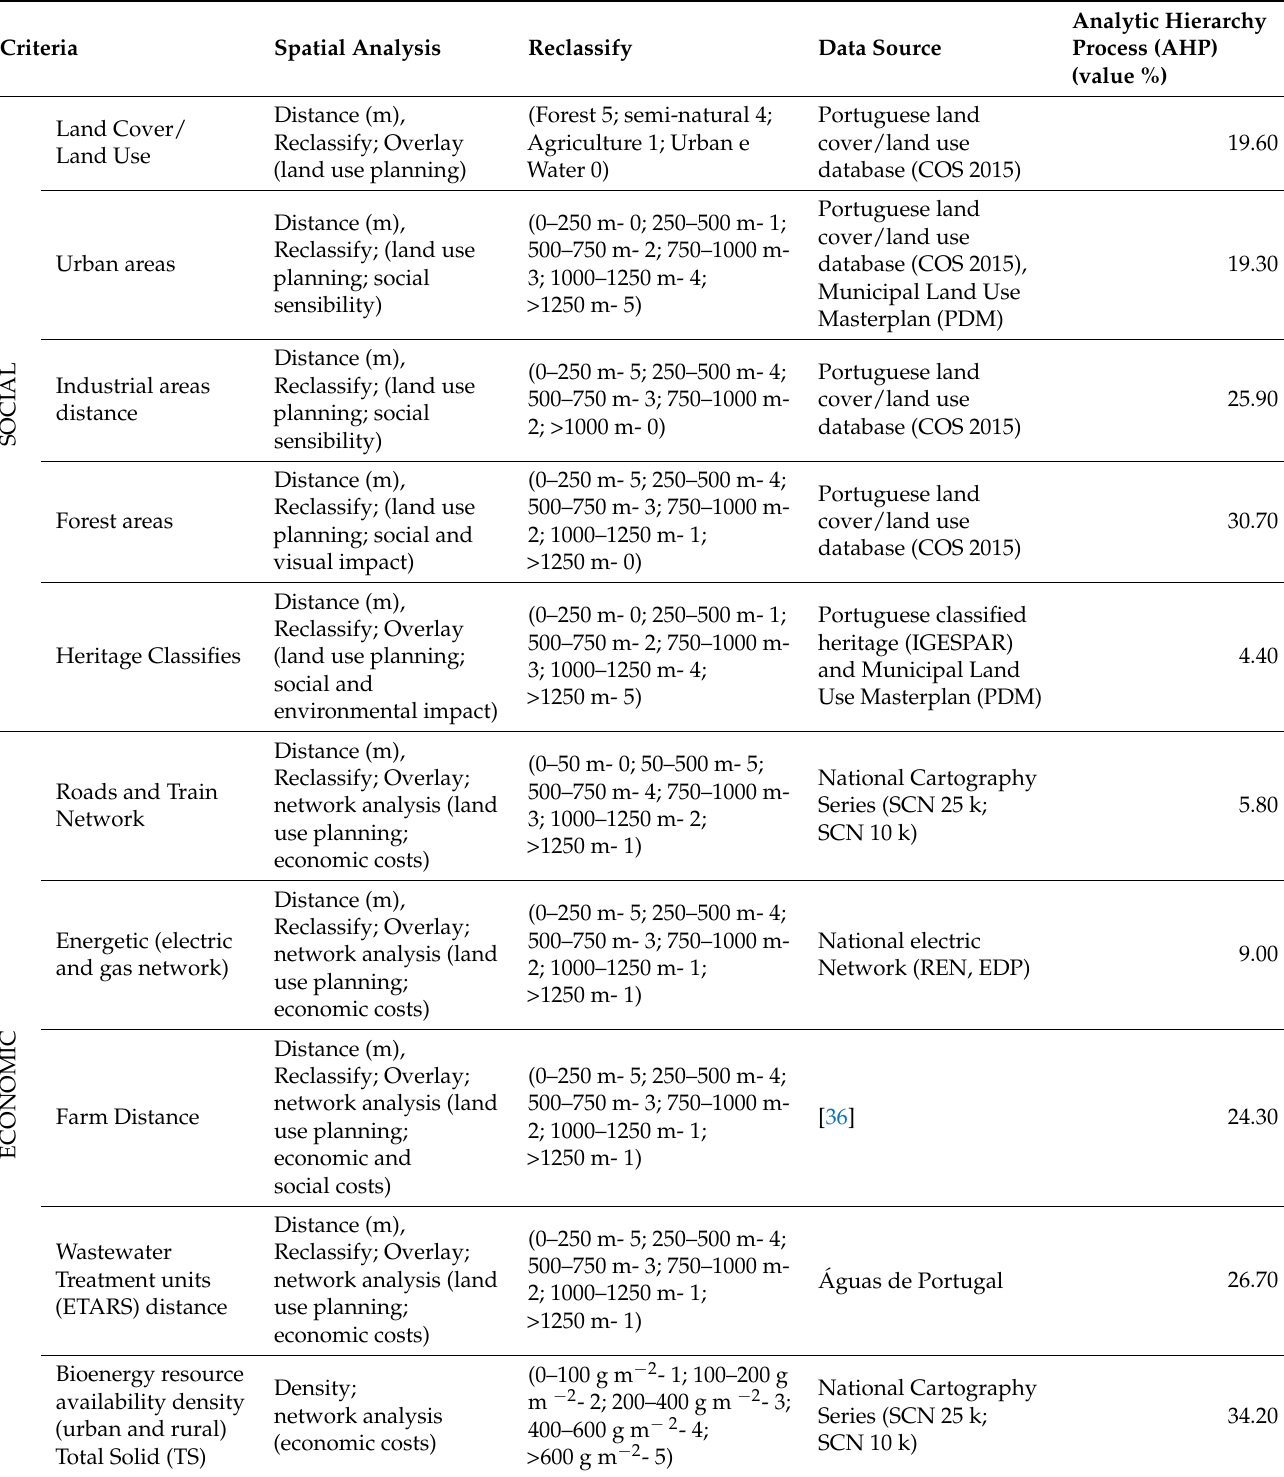
management towards environmental protection) (Table 1). Each criterion and dataset is standardized in spatial reference systems (ETRS89 TM06), and final thematic criteria values were reclassified into categorical scales (0 for exclusion, and a scale from 1, low value, to 5, optimal value) (Table 1). Table 1. Social, economic and environmental criteria and spatial analysis included in fuzzy multicriteria spatially ex- plicit